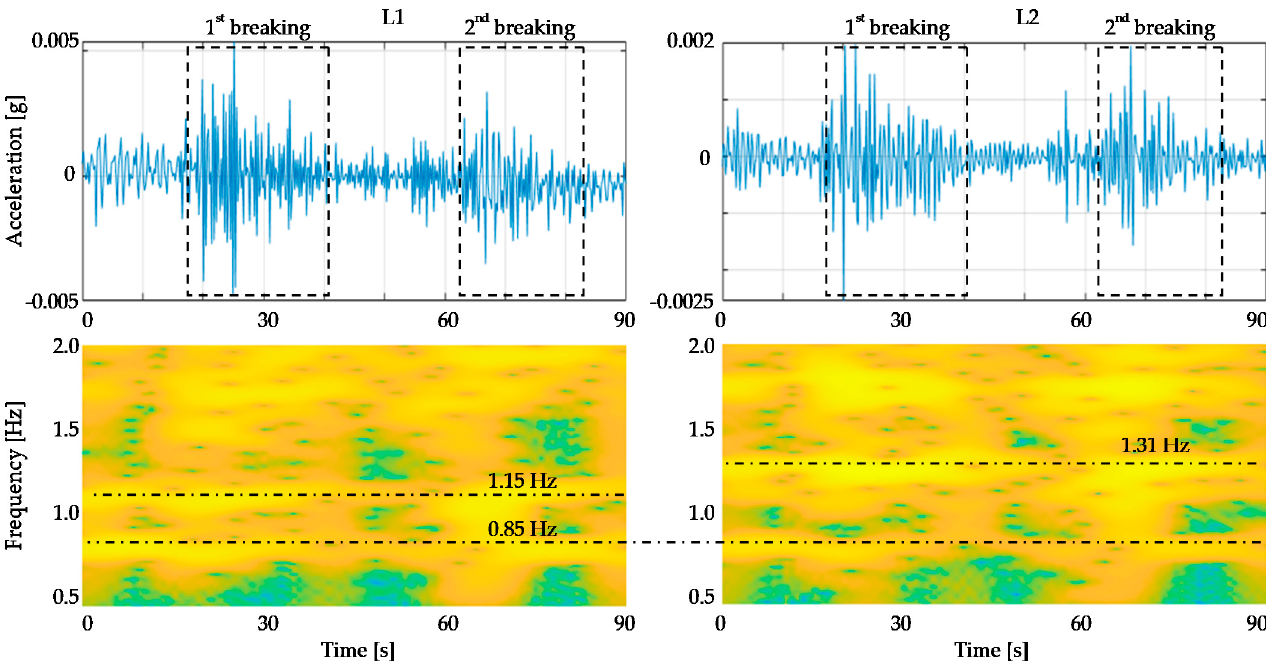
Figure 20. Acceleration time histories and relevant STFTs for the L1 and L2 sensors during the BLTs.